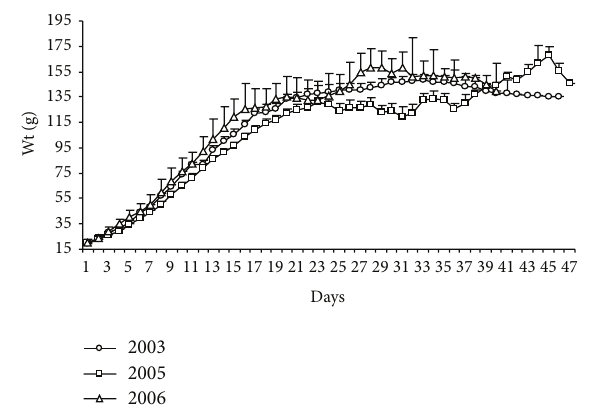
Figure 13: Daily increase in the weight (g) of Sterna hirundinacea chicks.